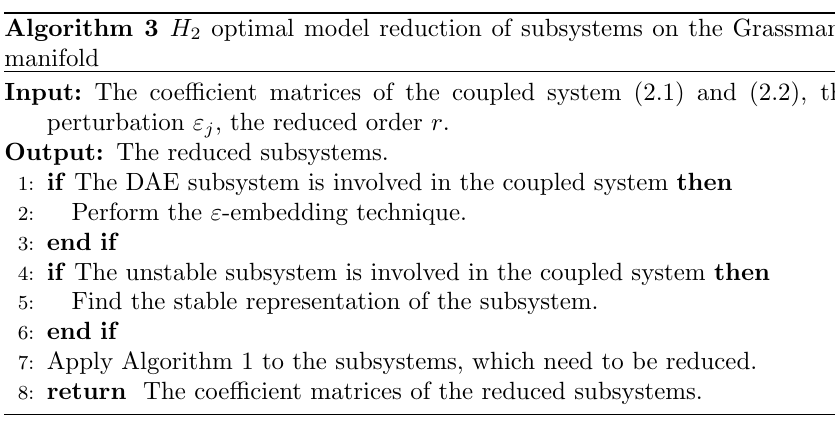
Algorithm 3 H 2 optimal model reduction of subsystems on the Grassmann